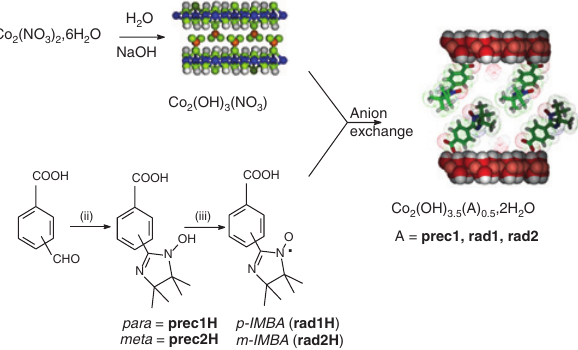
Figure 7: Grafting benzoate nitroxide radicals by anion exchange in cobalt(II) hydroxy nitrate and structural model. Adapted with permission from [91]. Copyright 1998 Wiley.